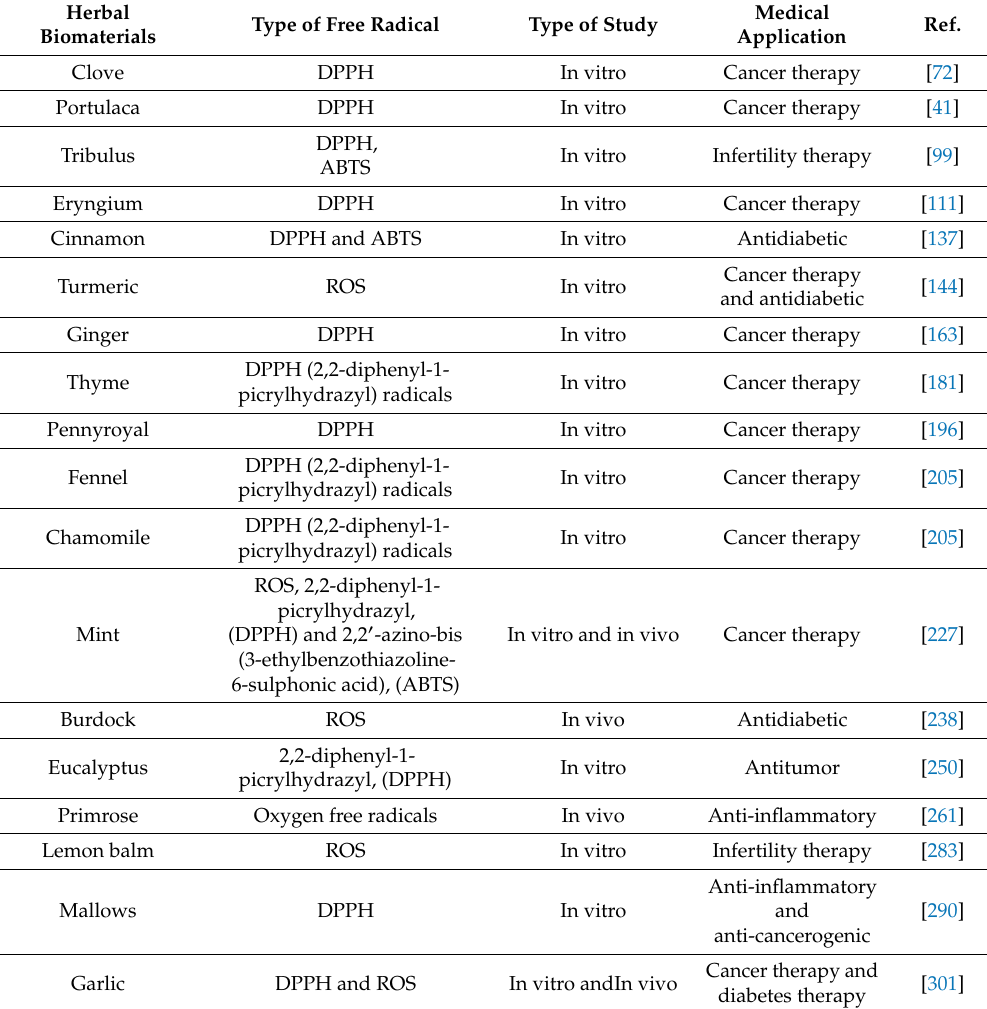
Table 4. Antioxidant activity of herbal